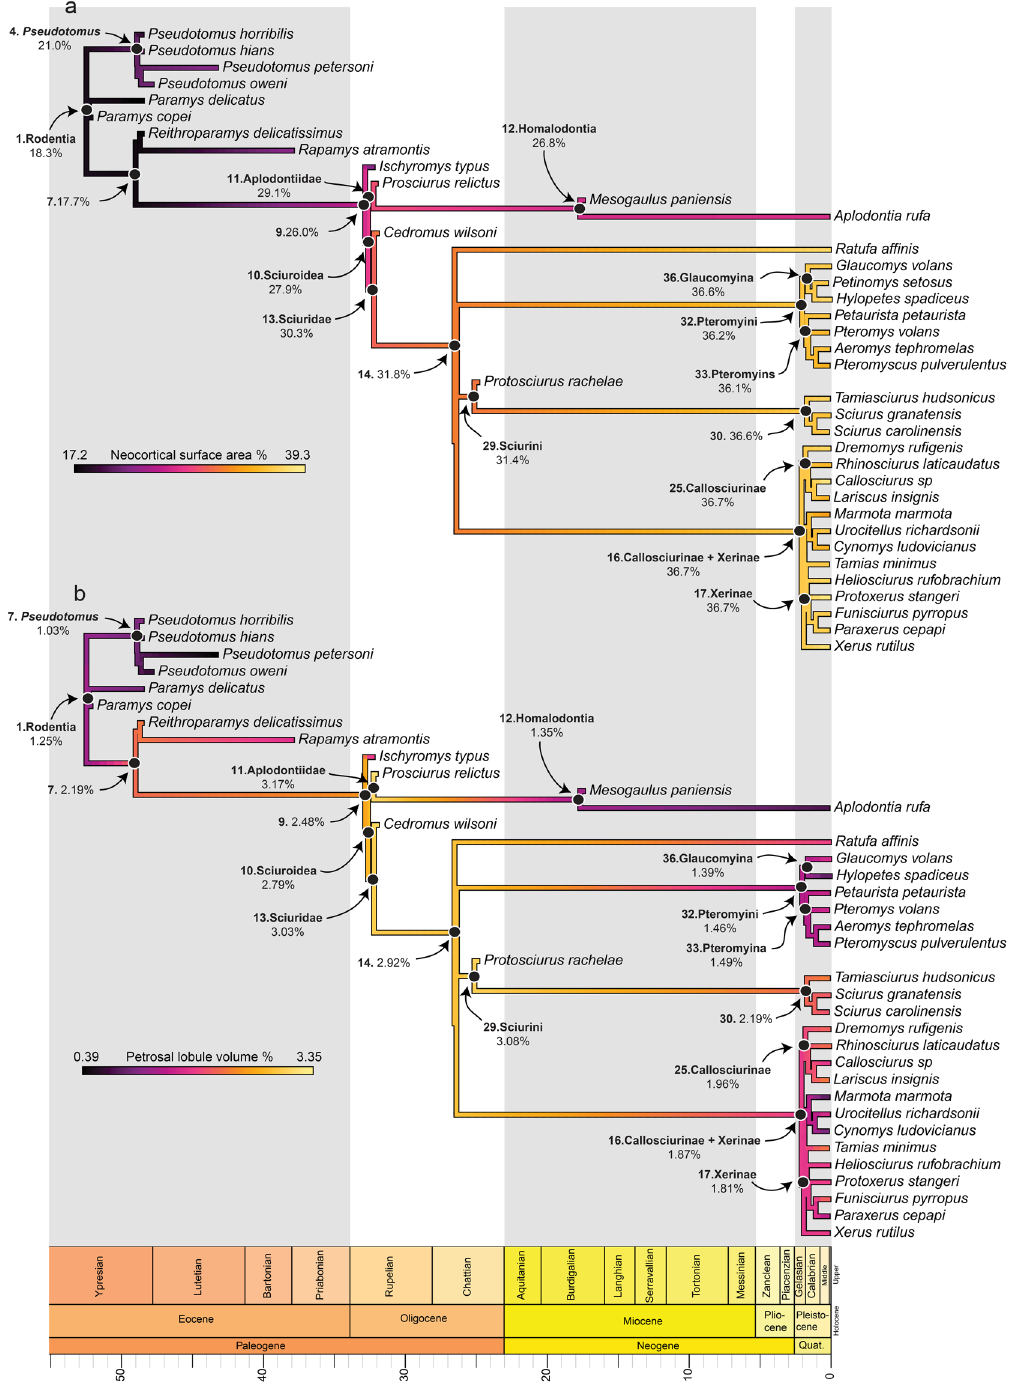
Fig. 5 Ancestral state reconstructions with a geological timescale. a Neocortical surface area percentage; b Petrosal lobule volume